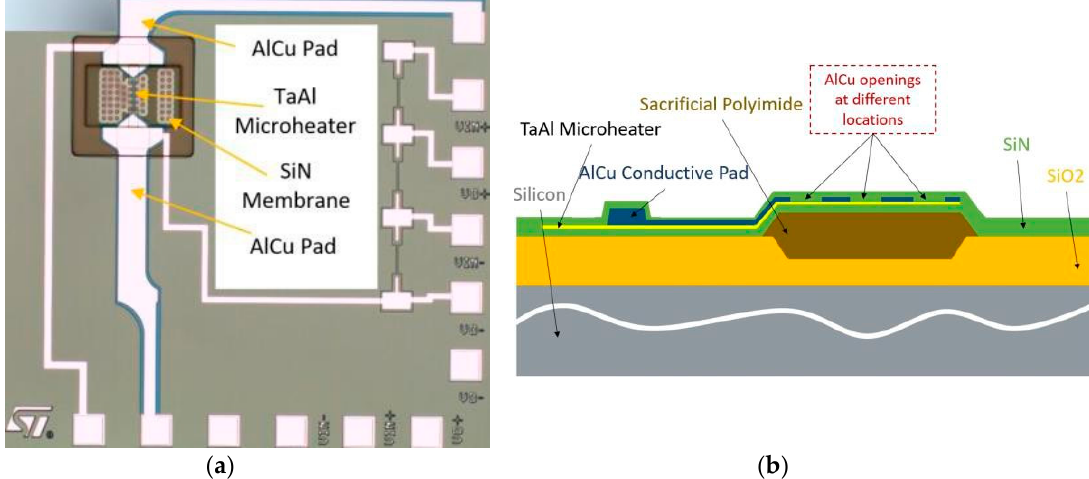
Figure 2. Structure of the SMO gas sensors. ( a ) Top view of the initial D02 design. ( b ) Cross section of the novel composite heater design with the AlCu openings. To form the gas sensor membrane, the sacrificial polyimide was etched as the last step in the fabrication sequence using selective plasma etching in order to achieve low power consumption and good thermal